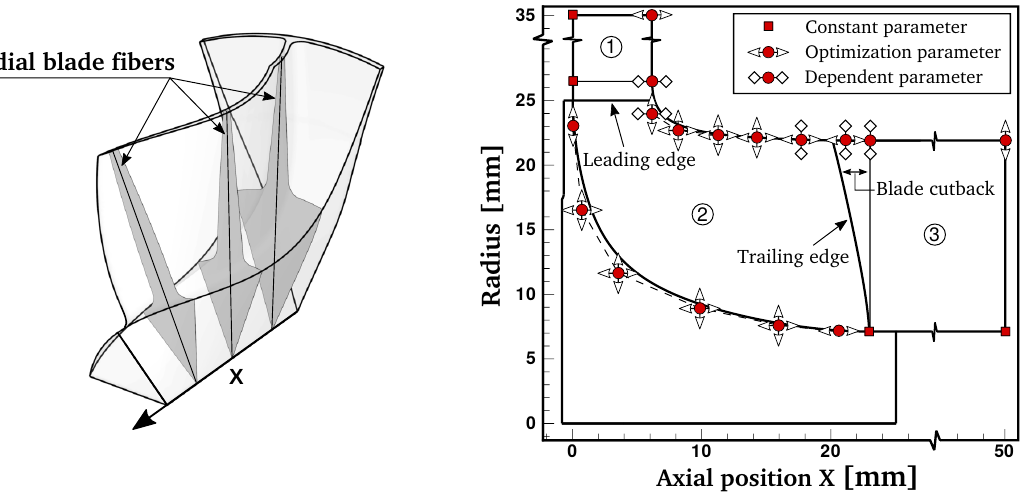
Figure 2. Radial fibered blade sections of the turbine wheel ( left ); parameterization of the meridional flow path with three patches (cid:172) – (cid:174) ( right